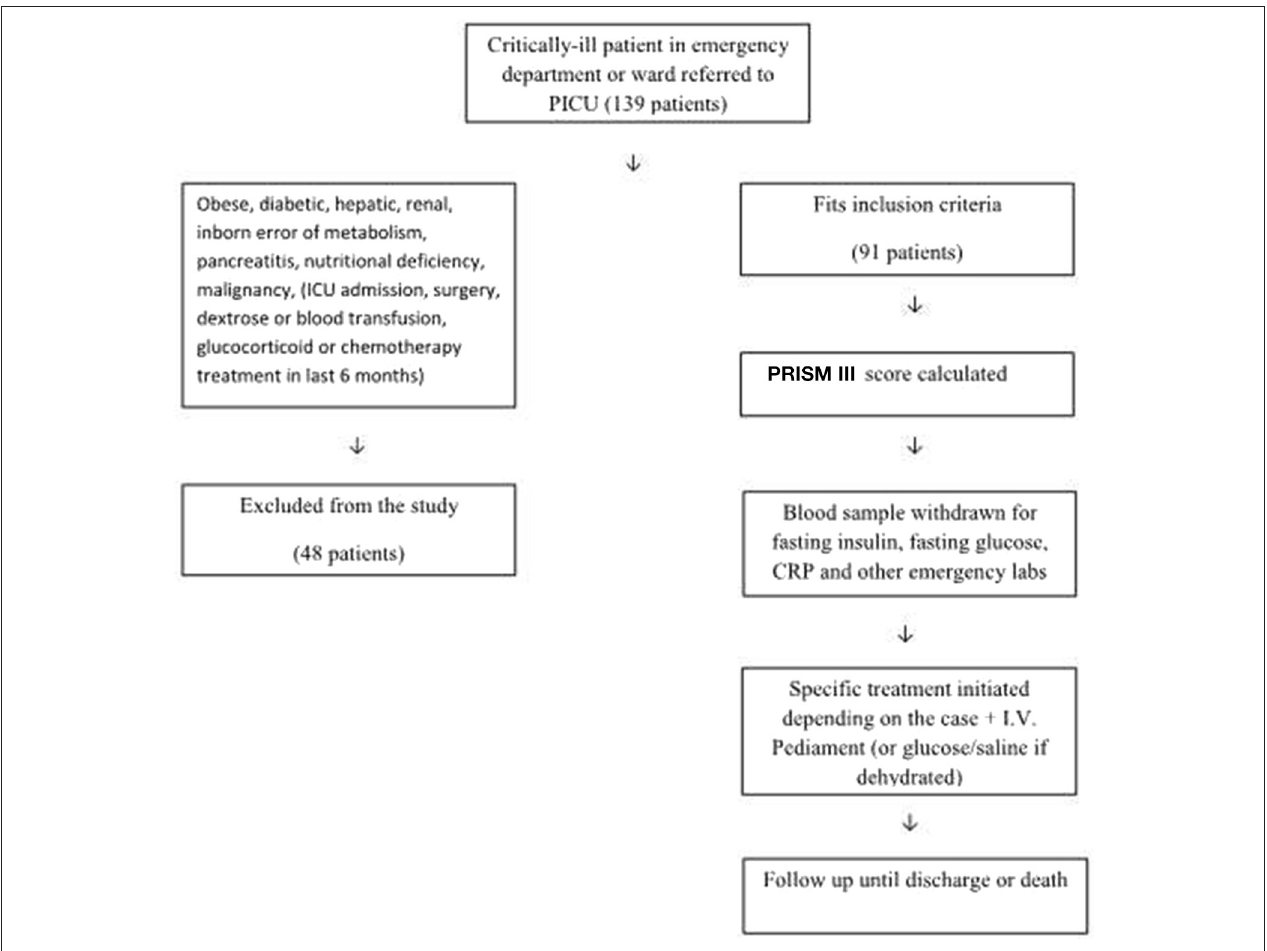
FIGURE 1 | Flow diagram for recruitment and assessment of β -cell function in critically-ill